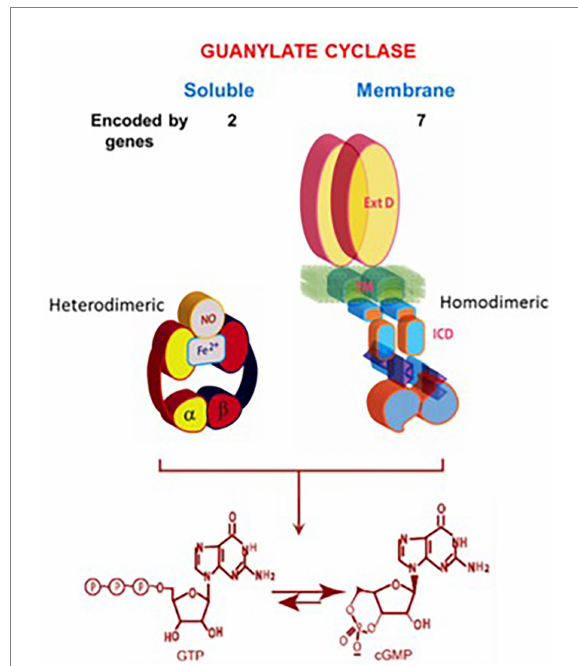
FIGURE 3 Soluble vs . membrane guanylate cyclase. Upper panel: Graphical representation of soluble and membrane guanylate cyclases. The soluble form is encoded by two genes; it is heterodimeric (subunits α and β ) and requires heme for its activity. Both monomers contribute to the catalytic center, but their orientation is unknown yet (Allerston et al., 2013). The membrane guanylate cyclase is encoded by seven genes. It is a single transmembrane spanning protein. The extracellular domain (Ext) is located outside the cell; the transmembrane domain (TM) spans the plasma membrane; and the intracellular domain (ICD) is located inside the cell. The active form is homodimeric. The cyclase catalytic domain is located at the C-terminus of the protein. Both monomers in antiparallel orientation contribute to the catalytic center. Lower panel: Both cyclases are lyases (EC4.6.1.2) and catalyze synthesis of cyclic GMP from GTP. (From: (Sharma and Duda,